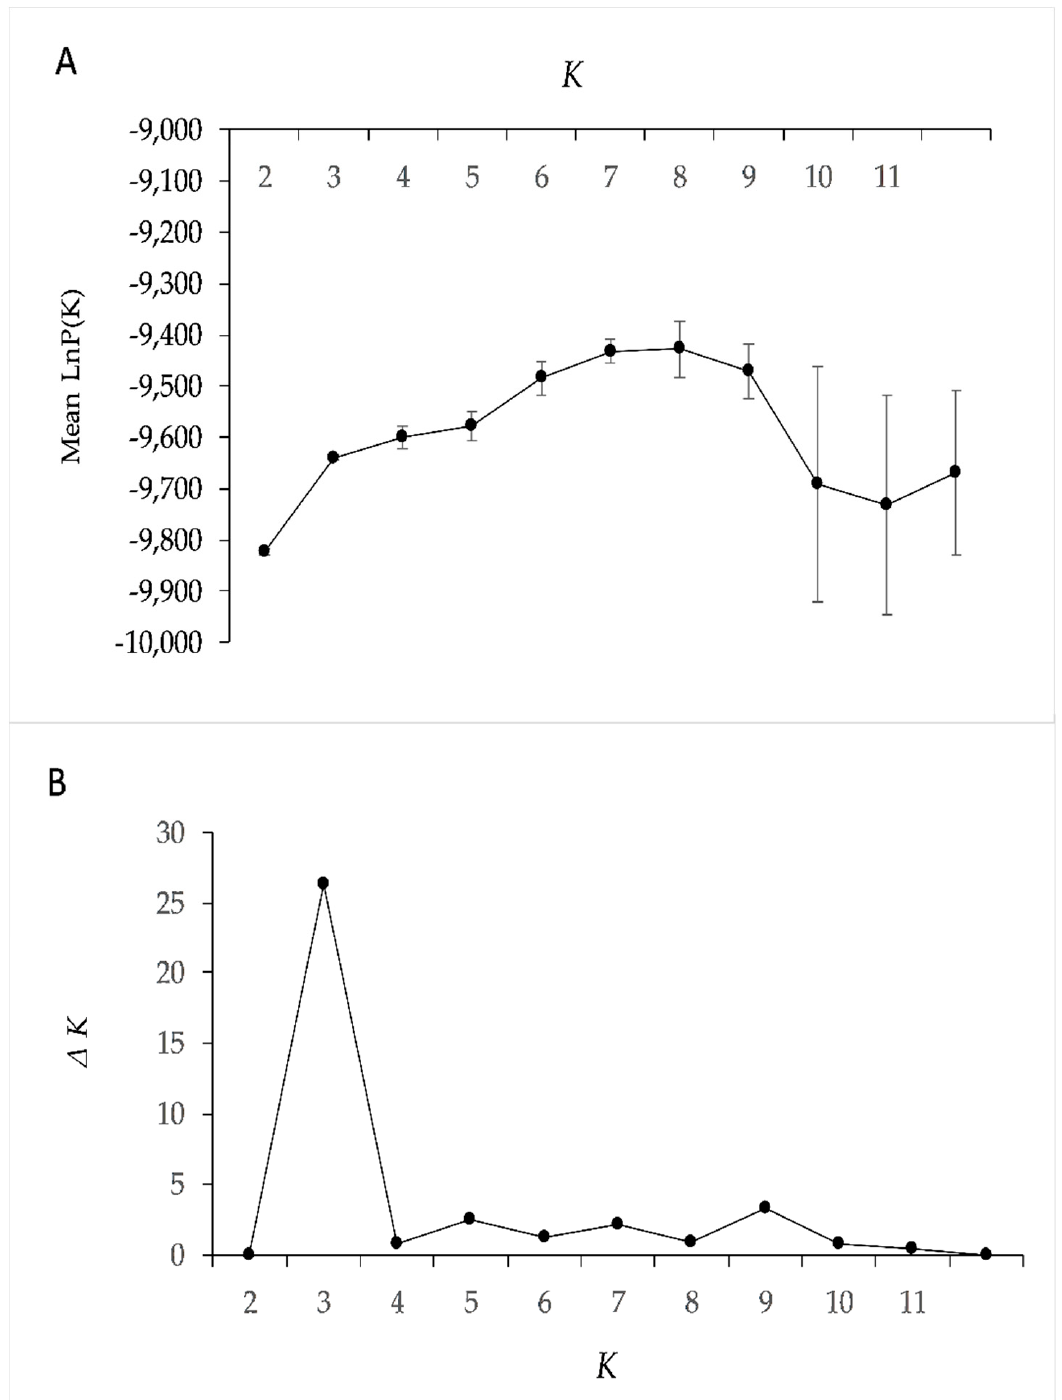
Figure 3. Mean LnP( K ) ( A ) and ∆ K ( B ) plotted on number of clusters K by means of the STRUCTURE-HARVESTER software.